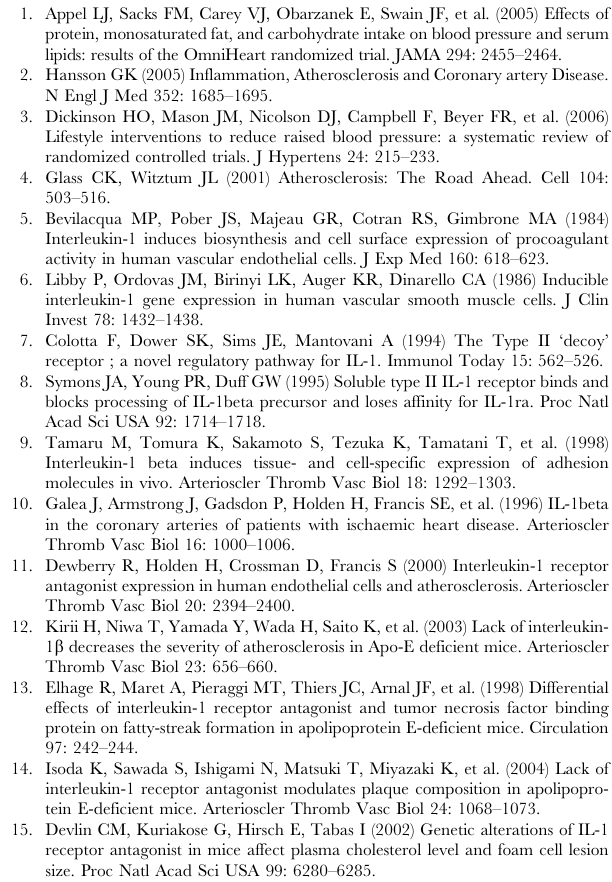
Figure S5 ROS and Nox 4 expression in endothelial cells in culture. Increased ROS are seen following IL-1 b stimulation of endothelial cells isolated from Apoe 2 / 2 mice (n= 6) (a) and human coronary endothelial cells (hCAEC) (n= 6) (b). However, no increase in ROS are seen in ECs isolated from Apoe 2 / 2 /IL- 1R1 2 / 2 mice (n= 6) (a). Nox 4 mRNA expression is increased in hCAEC stimulated with IL-1 b (n= 5) (c). Figure S6 ROS and Nox 4 expression in vascular smooth muscle cells in culture. No significant difference in ROS are seen following IL-1 b stimulation of VSMCs (n= 6) (a). Nox 4 mRNA expression is decreased in VSMC stimulated with IL-1 b (n =1) (b). Figure S7 ROS generation in Apoe 2 / 2 mice following feeding of a high fat diet. Mice fed WHC had significantly more ROS than those fed chow alone, with Western diet giving intermediate levels of ROS. (n= 9). Table S1 Lipid, glucose and ALT levels in ApoE 2 / 2 /IL-1R1 2 / 2 and ApoE 2 / 2 mice fed chow, Western High Cholate (WHC), and Western diets. Data represents mean + / 2 SEM.